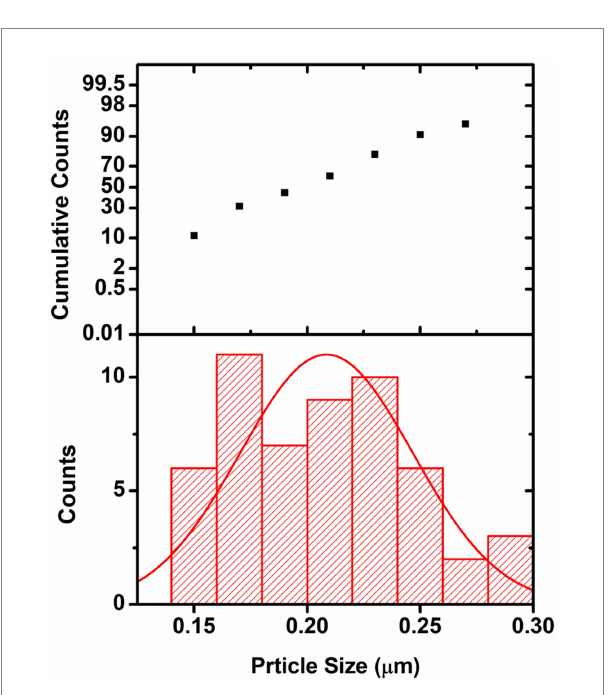
FIGURE 9 Graph showing the particle size distribution of Au-particles. The analysis was done considering the SEM-image Figure